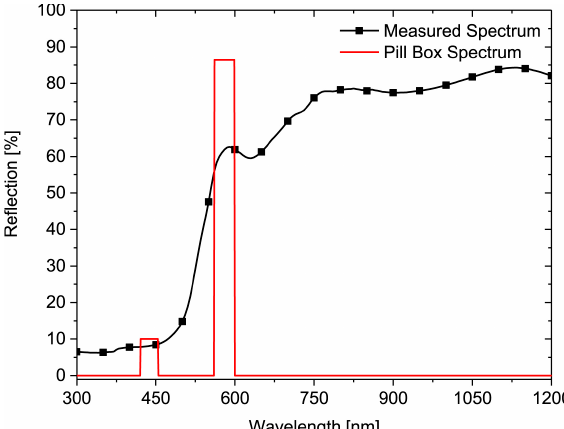
Figure 4. Example of the difference between measured and pill box reflection spectra of RAL colour 1004 “golden yellow”. Reproduced with permission from [16], copyright 2018, Elsevier.